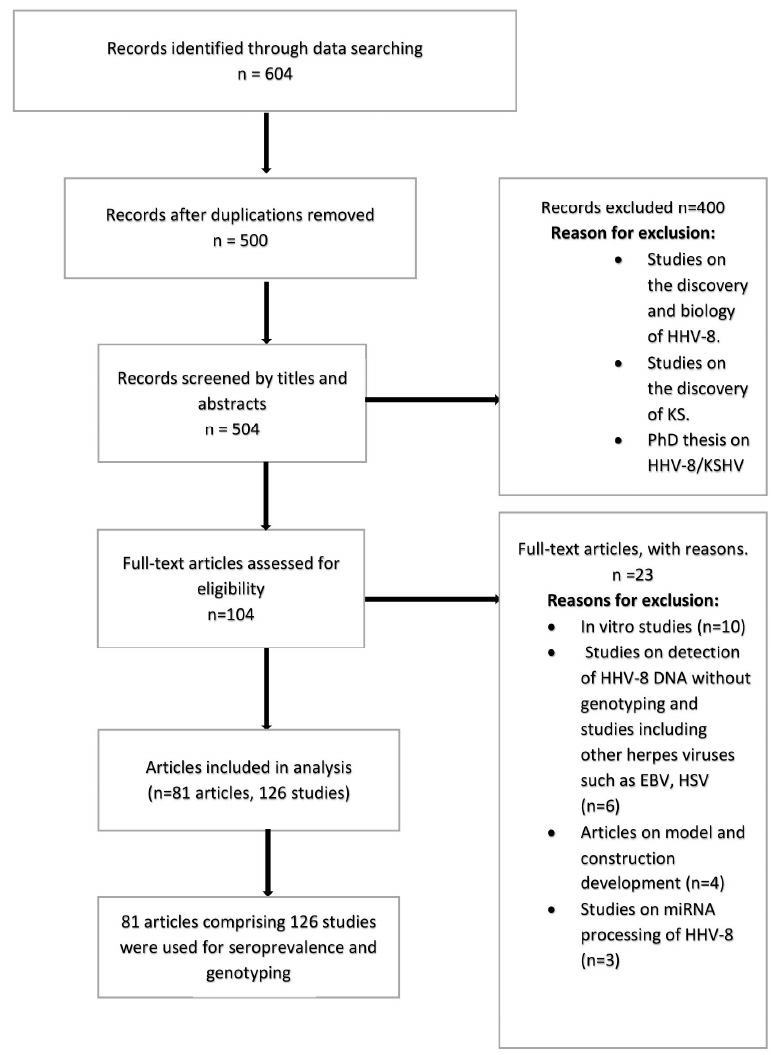
Figure 1. Flow chart on the selection of studies included for analysis.